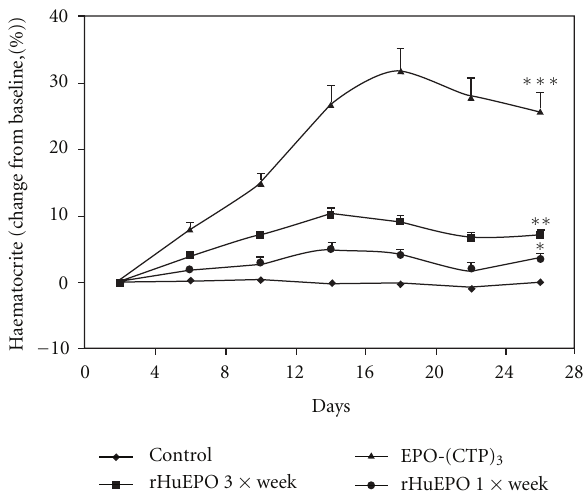
Figure 5: In vivo bioactivity of recombinant HuEPO derivatives. ICR mice ( n = 7/group) received a single IV injection/week (15mg/kg) for three weeks of EPO-WT, rHuEPO, or EPO-(CTP) 3 . In addition, mice were treated with 5 μ g/kg of rHuEPO three times a week for 3 weeks. Control animals were injected IV with saline. Blood samples were collected three times a week and haematocrit levels were detected. Each point represents the group average of